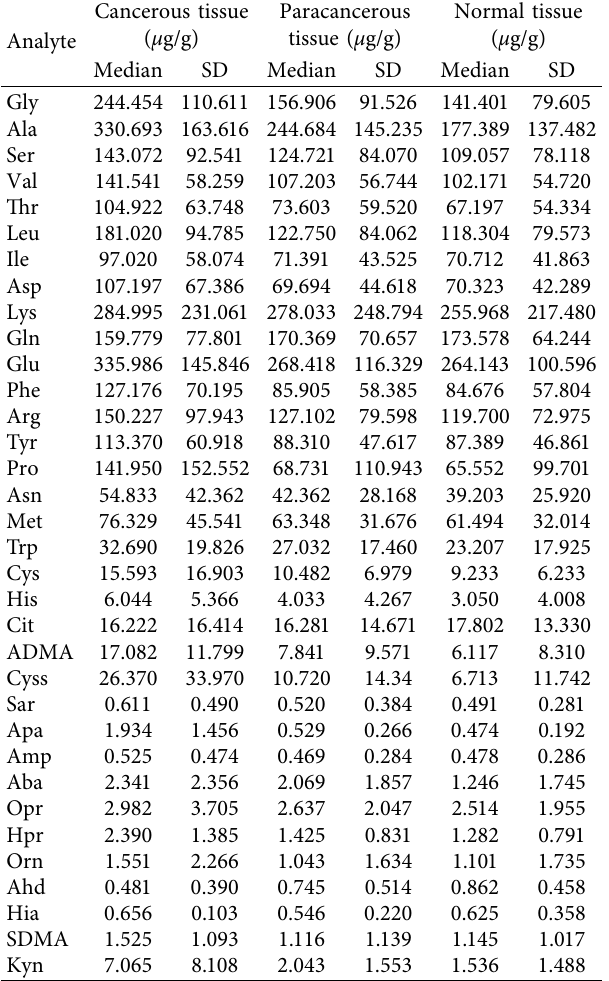
Table 5: The median and SD values of 34 amino acids in cancerous, paracancerous, and normal tissue from 94 CRC patients. Cancerous Analyte